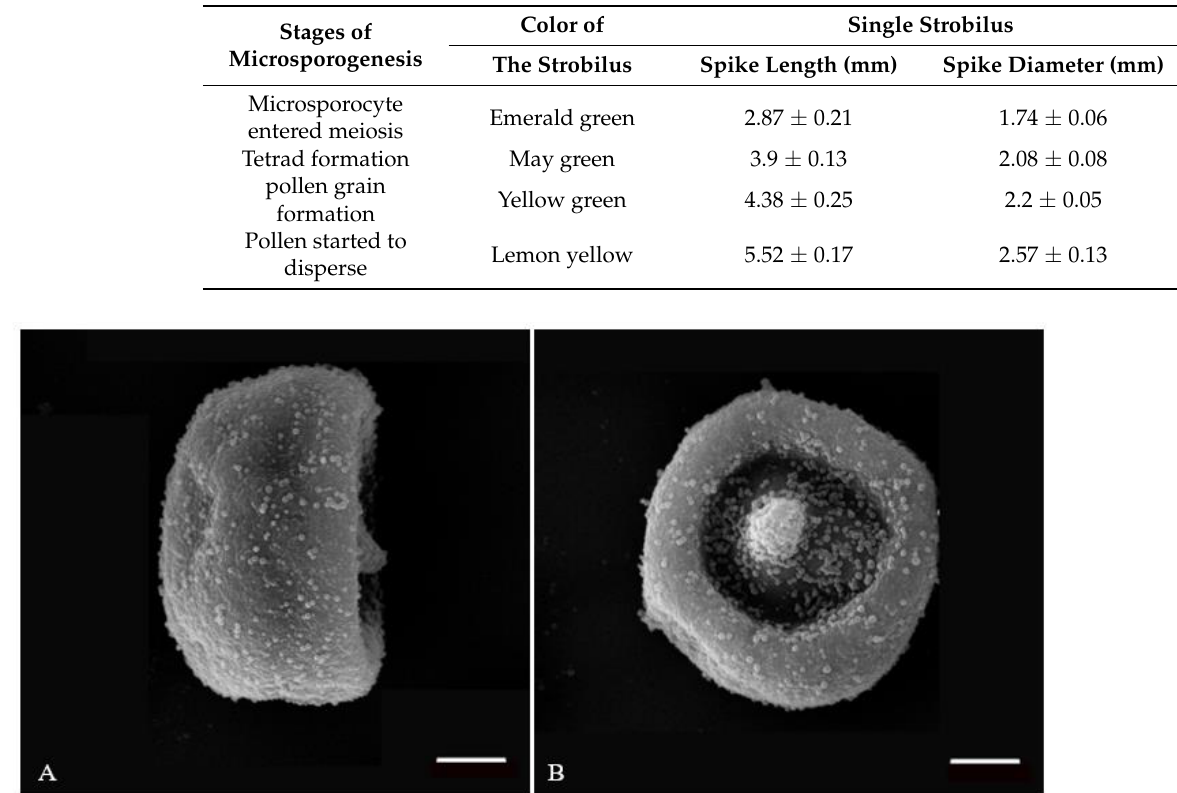
Figure 2. SEM photographs of pollen grains of T. distichum var. distichum . ( A ) Equatorial view at 4000×. ( B ) Polar view at 4000×. ( C ) Equatorial view at 10,000× showing pollen exine with microverrucate ornamentation ( arrow a), on which many granular protrusions ( arrow b) are observed. ( D ) Polar view at 10,000×. Bars: ( A , B ) 5 μm. ( C , D ) 2 μm. 3.2. Water Content of T. distichum var. distichum Pollen The determination result of water content of pollen of T. distichum var. distichum TD-4 and TD-5 are shown in Table 2. With the extension of storage time, the pollen water content of TD-4 and TD-5 decreased gradually, and the water content of fresh pollen was the highest, and the water content of pollen after three years storage was the lowest. In addition, after the first year of storage, pollen water content decreased the most, from 24.46% and 24.38% of fresh pollen to 14.35% and 15.48% of pollen after storage for one year, and pollen water content decreased by 41.33% and 36.51%, respectively.